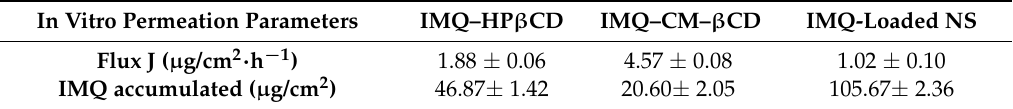
Table 3. Permeation parameters for IMQ–CD complexes and IMQ-loaded NS. Results are expressed as mean ± S.D. ( n = 3).